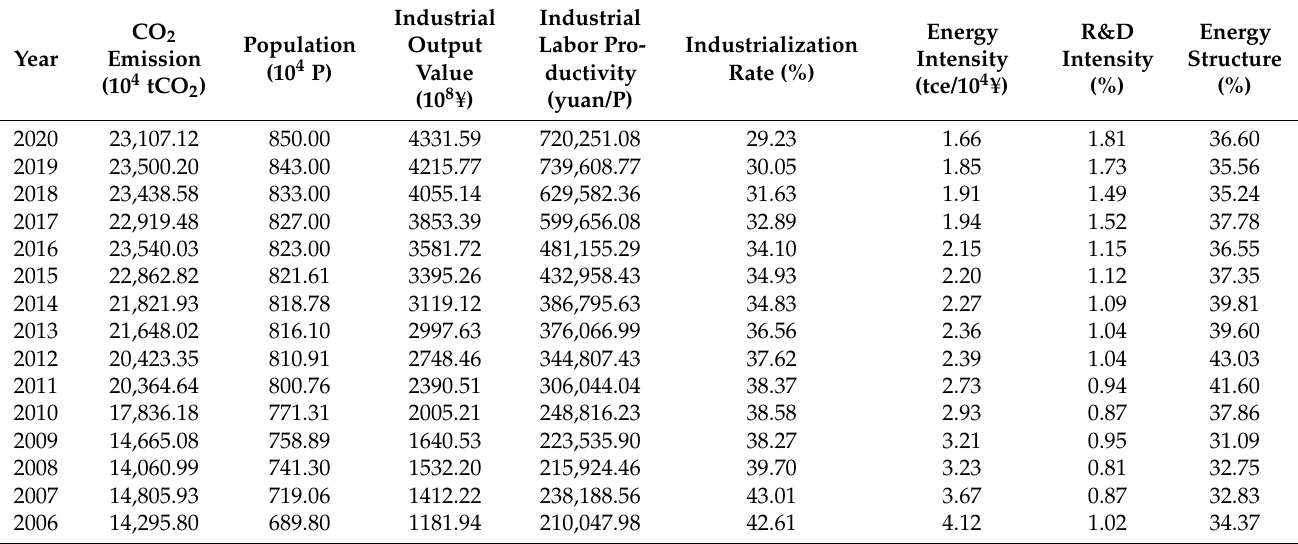
Table A1. Original data of influencing factors of industrial carbon emission in Nanjing from 2006 to